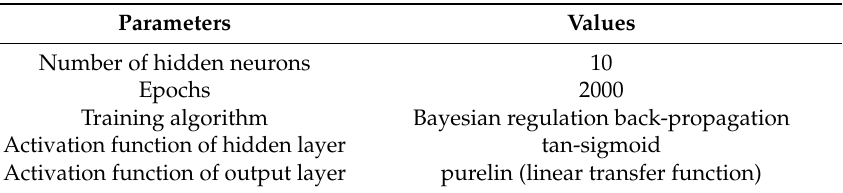
Table 4. Parameter settings of